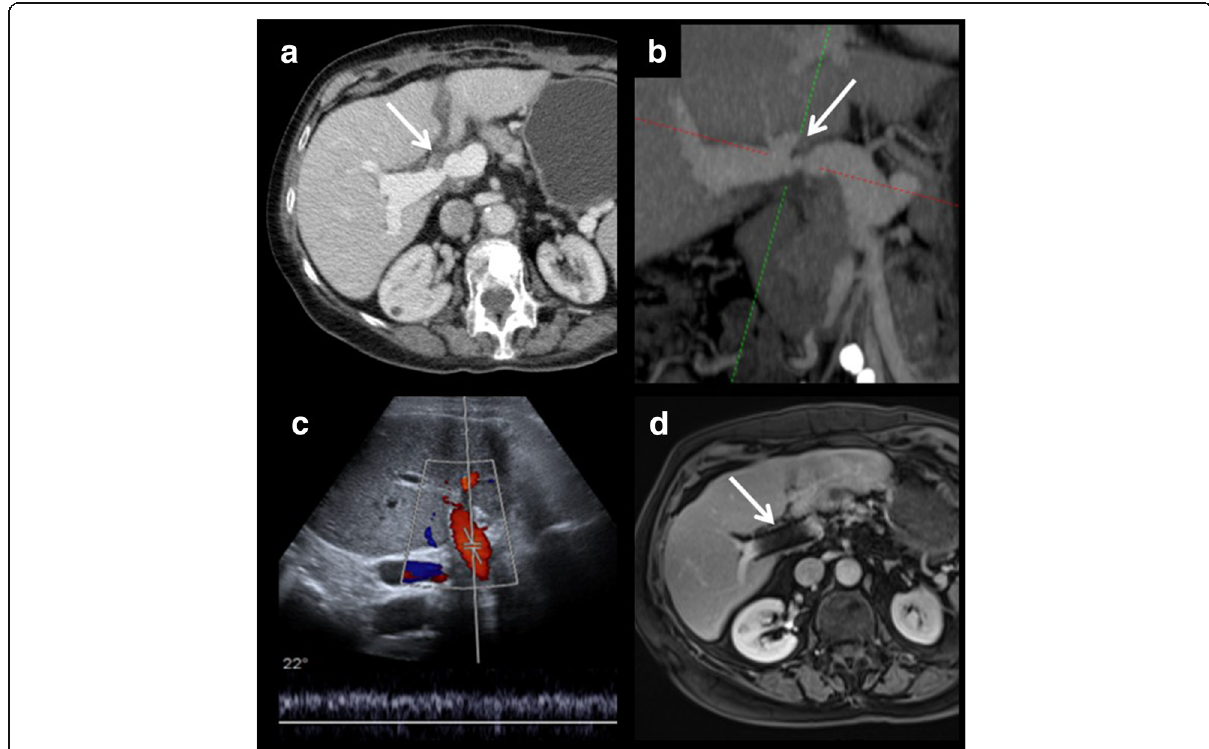
Fig. 11 Portal vein stenosis. Portal vein stenosis is demonstrated on CT, both on axial images ( a ) and in multiplanar reconstructions ( b ). After stent placement, a control ultrasound is performed ( c ). It shows normalisation of the portal flow. Control MRI ( d ) shows metallic artefact of the stent. Normal contrast enhancement is seen both proximal and distal to the stent